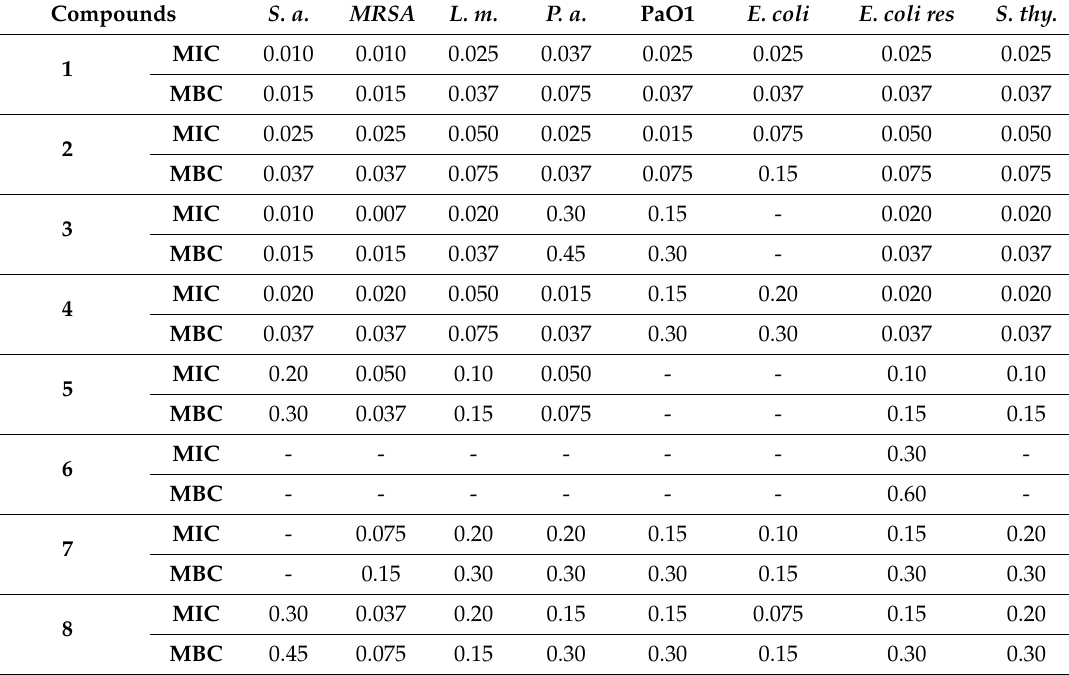
Table 3. Antibacterial activity of compounds 1–31 (MIC and MBC in mg / mL).